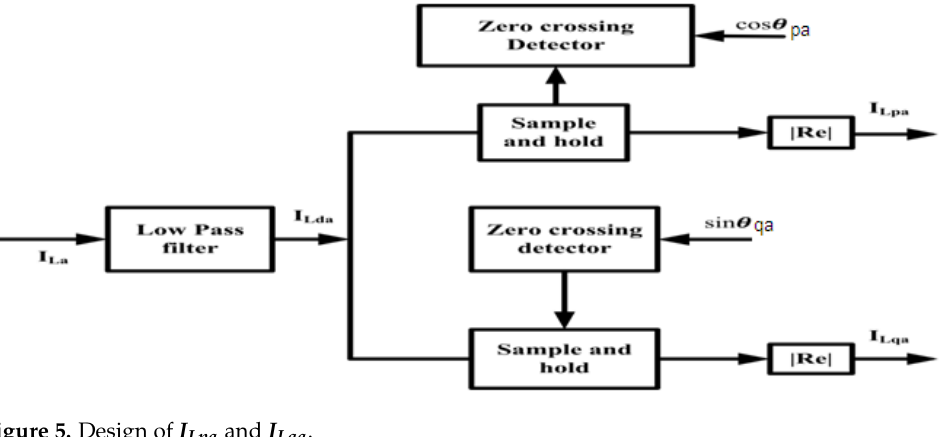
Figure 5. Design of I Lpa and I Lqa . Step 5: Calculation of amplitude of the d-axis component of load current 𝑰𝑰 𝑳𝑳𝒂𝒂𝒂𝒂 The Figure 6 represents the design of amplitude of d-axis load current.